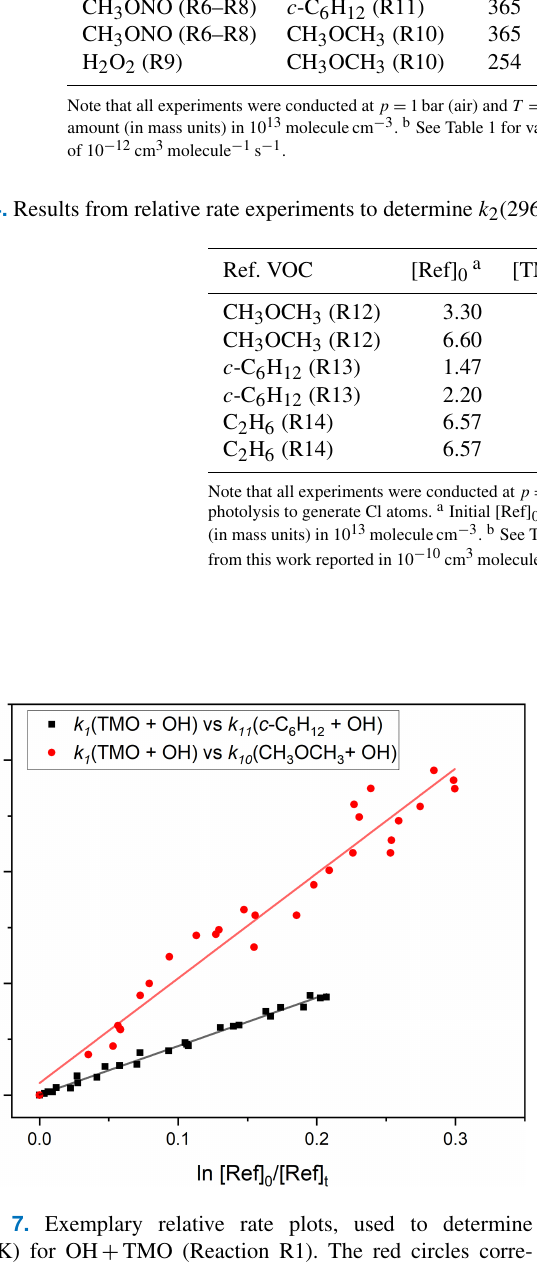
Figure 8. Exemplary relative rate plots used to determine k 2 (296K) for Cl + TMO (Reaction R2). Gradients obtained from linear fits (the solid lines) were used in conjunction with literature data (Ta- ble 1) to obtain k 2 . Each experiment was repeated twice, and the full results, summarised in Table 4, were averaged to obtain k 2 (296K)